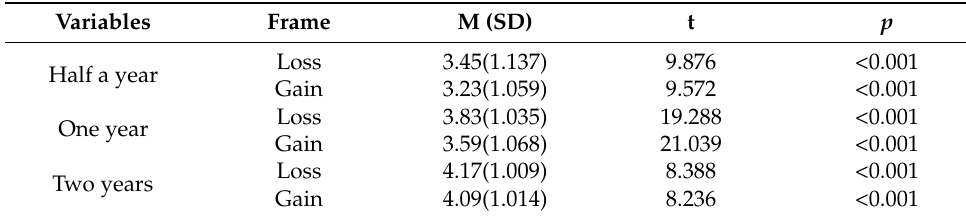
Table 9. Effect of duration of vaccine protection on vaccination